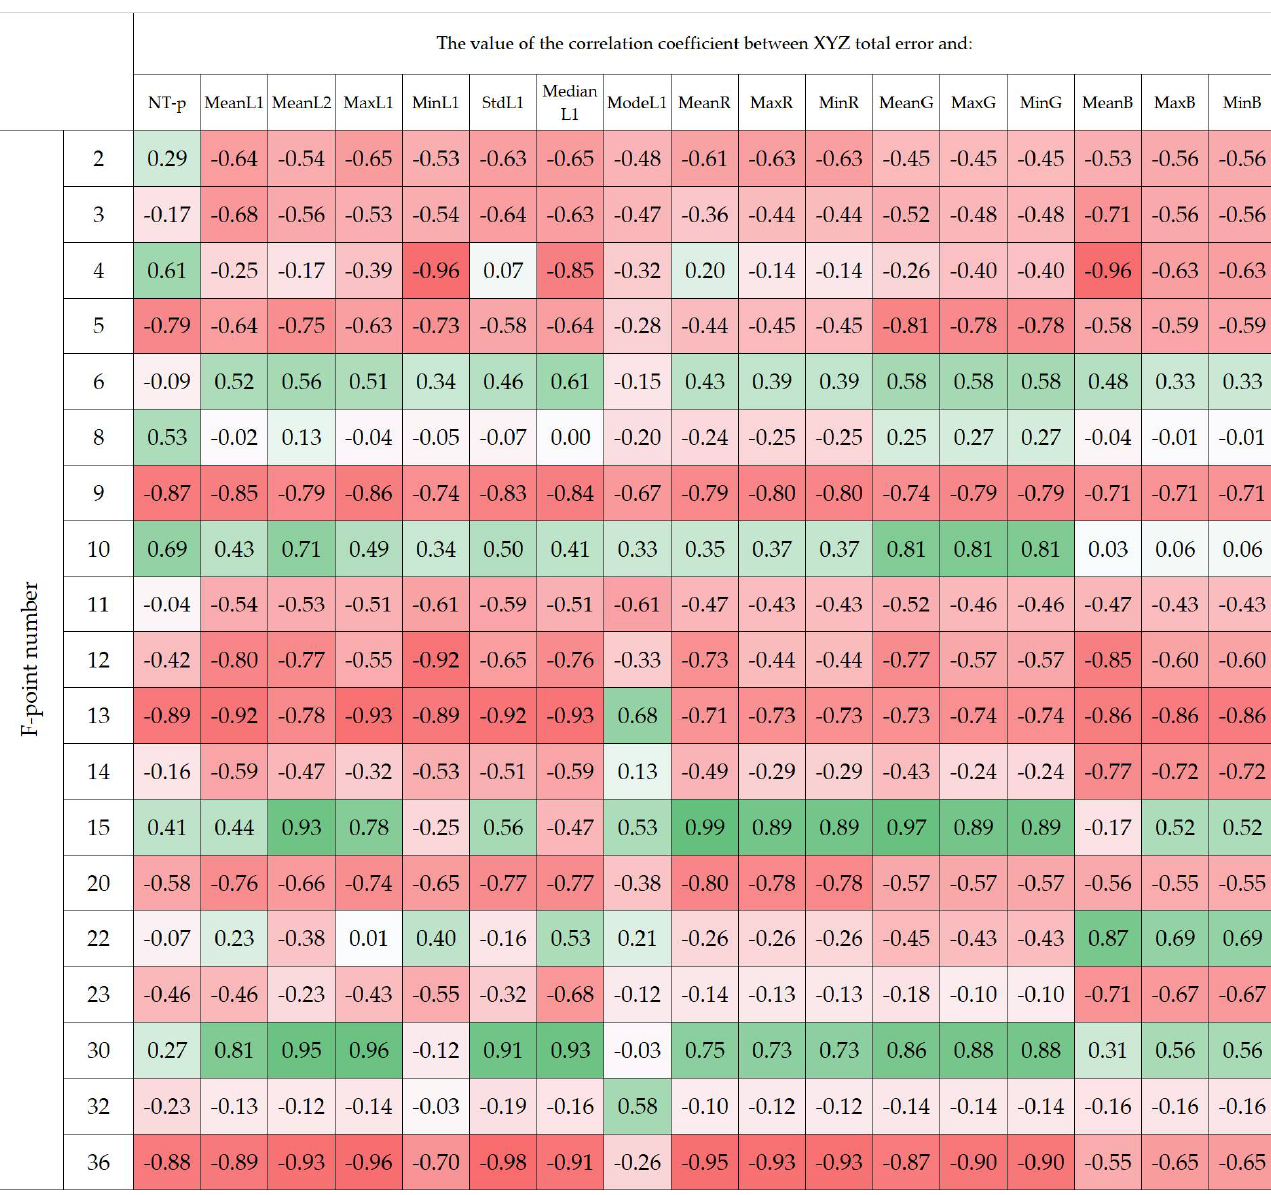
relation coefficients between the XYZ total error and most features concerning the lumi- nosity and the recorded spectral response for most F-points point to inverse correlations of various strength. Some points strongly deviate from the norm (F-points: 6, 10, 15, 30) and demonstrate a substantially higher XYZ total error.